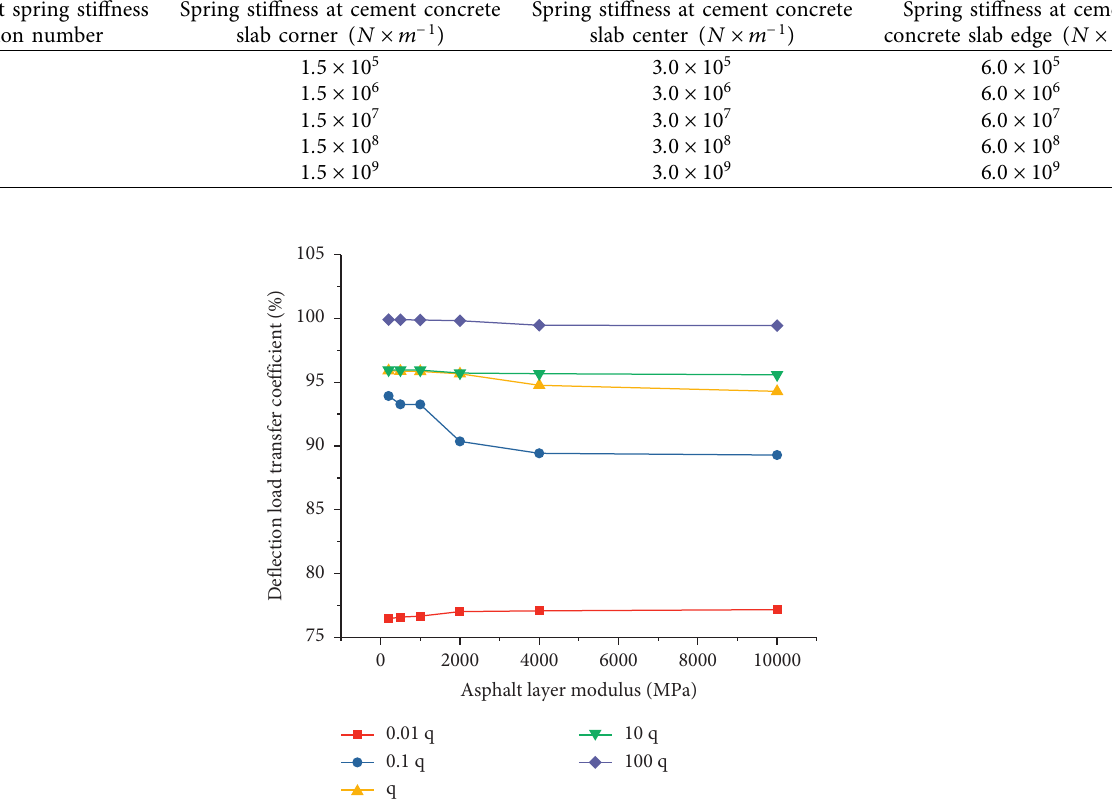
Figure 7: Variation of deflection load transfer coefficient with respect to the asphalt layer elastic modulus under different values of spring stiffness.